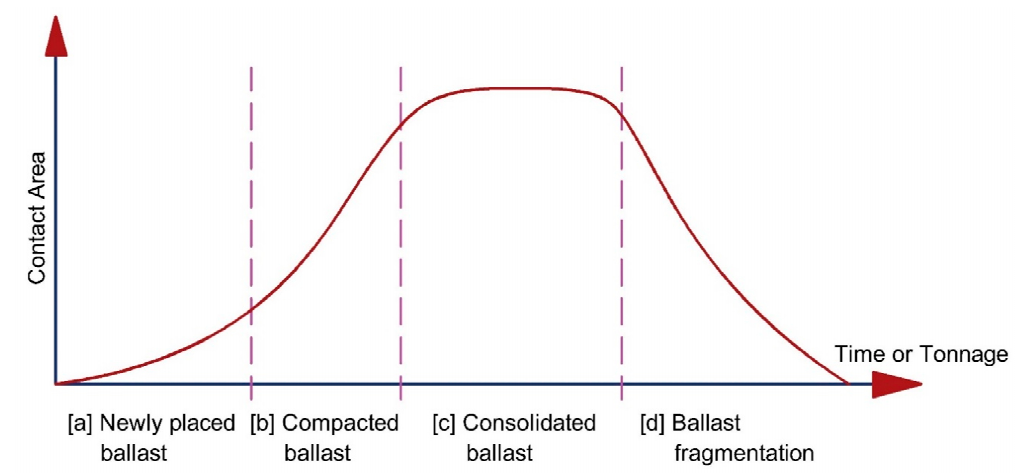
Figure 5. Time- and load-bound variation in ballast aggregate–aggregate contact area.